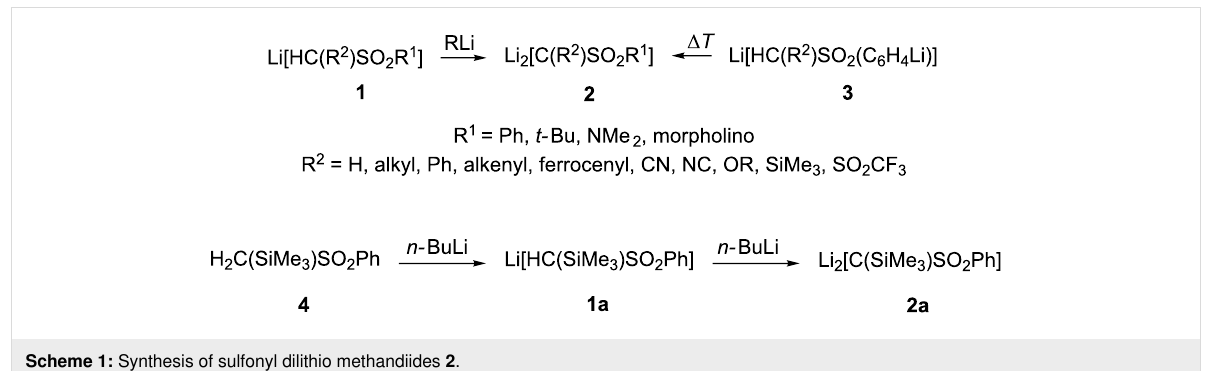
Scheme 1: Synthesis of sulfonyl dilithio methandiides 2 .